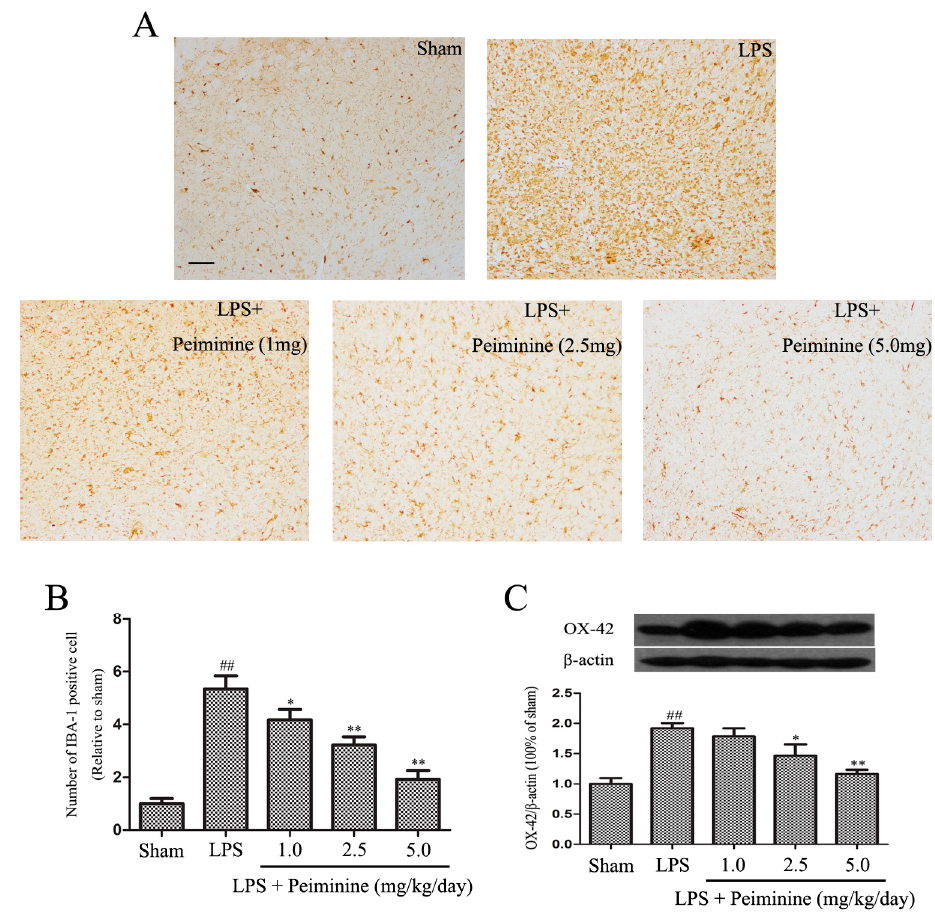
Figure 3. Peiminine suppresses the LPS-induced activation of microglia. PD model rats were decapitated on day 28 to obtain the midbrain. ( A ) The morphological changes of the microglia in the SN as shown by IBA-1 immunostaining. Representative photomicrographs of the SN area are shown. The magnification of the images is 40 × and the scale bar represents 400 µ m ( n = 4 rats per group); ( B ) Number of IBA-1-positive cells ( n = 4 rats per group); ( C ) OX-42 expression ( n = 4 rats per group). ## p < 0.01 compared to the sham group, * p < 0.05 and ** p < 0.01 compared to the LPS group.